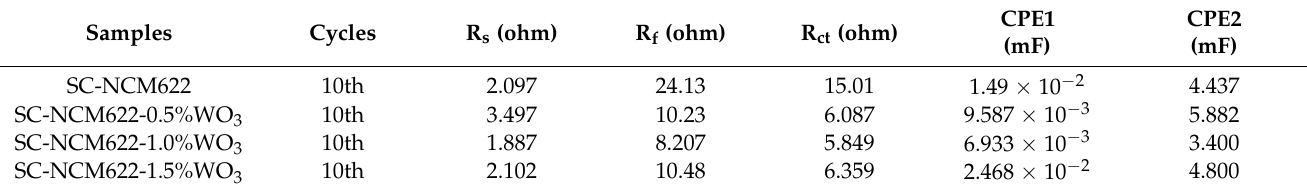
Table 2. The kinetic parameters of SC-NCM622, SC-NCM622-0.5%WO 3 , SC-NCM622-1.0%WO 3 and